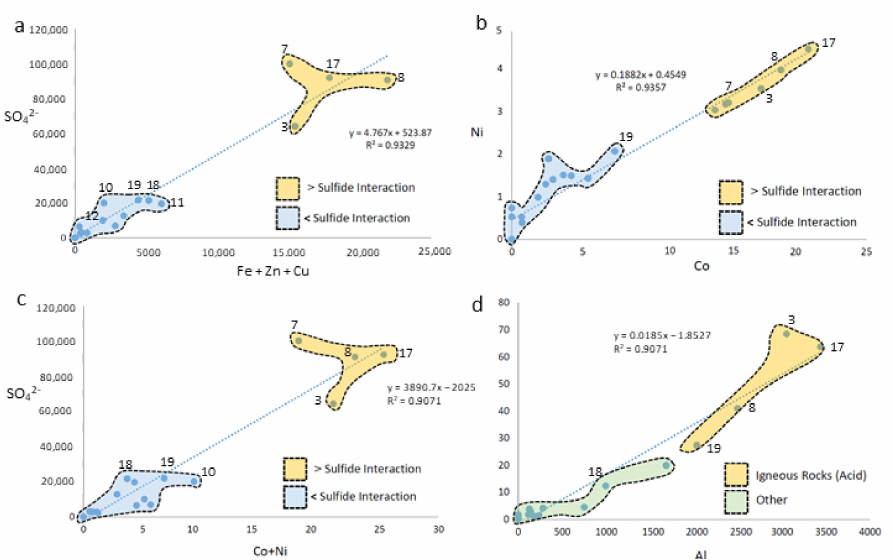
Figure 14. Correlation between different elements and anions showing a lithological control in some springs as the concentration of and between the sum of copper, iron and zinc against the total sulfate ( a ), cobalt against nickel ( b ), the sum of cobalt and nickel concentrations against the concentration of sulfate ( c ), and aluminum against fluorine ( d ). Element and anion concentrations are expressed in mg · L − 1 . See Tables 4 and 5 to identify the different springs in the correlation